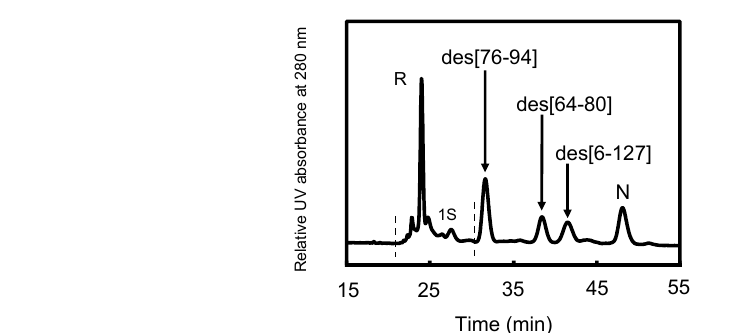
Figure 5. A reverse-phase HPLC chromatogram of the sample solution (with AEMTS blocking) obtained from the reduction pulse experiment of HEL using DTT red as a reductant at 5 °C and pH 8.0 in the presence of 2 M urea. Folding conditions were [R] = [DHS ox ] /3 = 9.1 µM for 240 min. The reduction pulse conditions were 6 mM 0 0 DTT red for 3